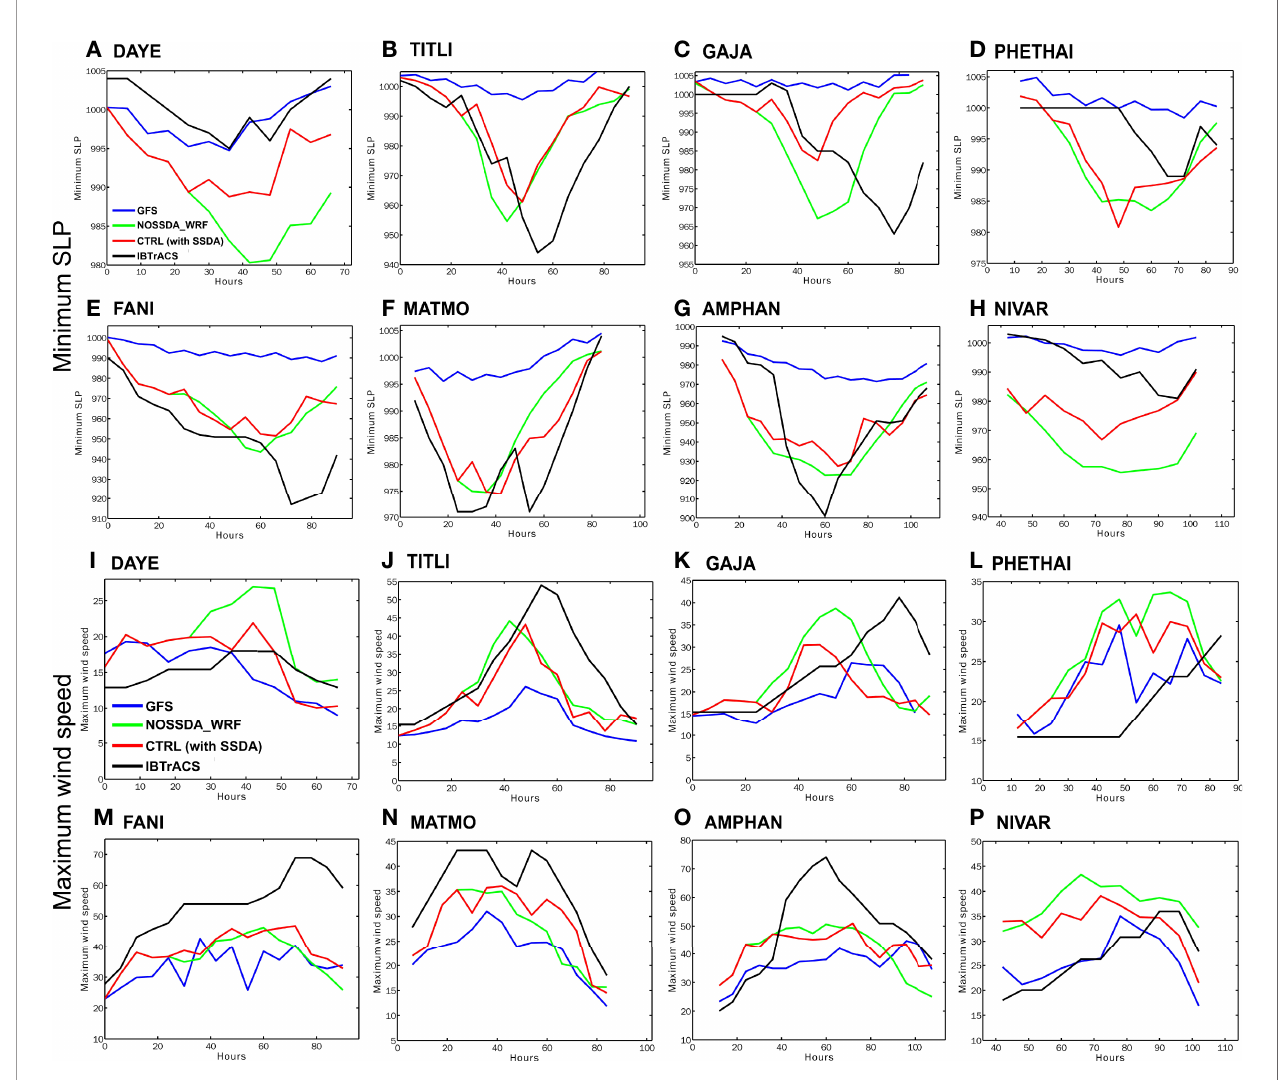
FIGURE 10 | The minimum sea-level pressure (SLP, unit: hPa; panels A – H ) and maximum wind speed (MWS, unit: knots; panels i-p) forecasted by GFS, NOSSDA_WRF, and CTRL (with SSDA), and obtained from IBTrACS Best track data for (A, I) DAYE, (B, J) TITLI, (C, K) GAJA, (D, L) PHETHAI, (E, M) FANI, (F,